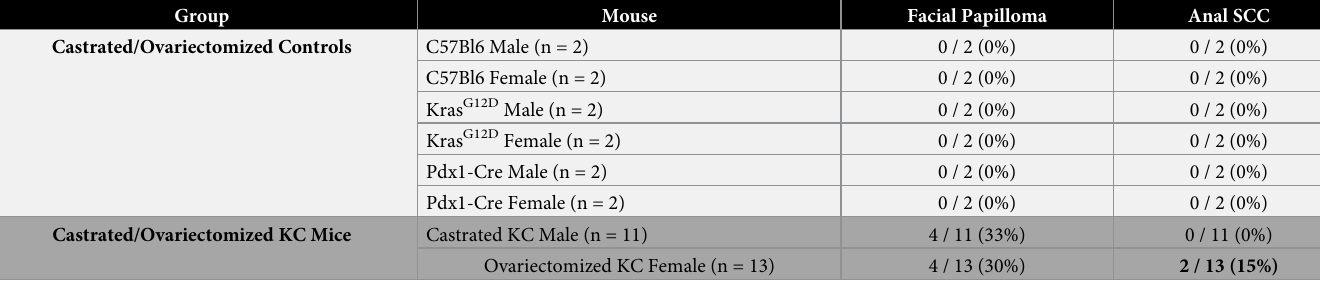
Table 2. Sex-dependent incidence of skin and anal lesions after castration or ovariectomy.